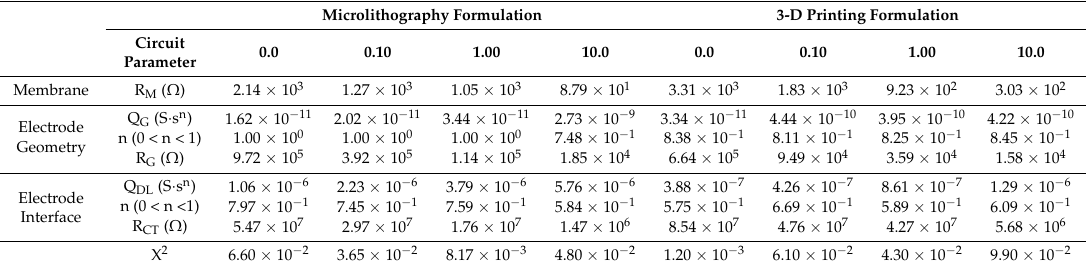
Figure 6. Nyquist plots of electroconductive hydrogels (ECH) containing 0.0, 0.1, 1.0, and 10 wt% PAn-PAAMPSA measured at room temperature (RT) in air from 10 mHz to 1.0 MHz using a 10 mV peak-to-peak sine wave. ( A ) Hydrogels formulated for microlithography containing 2 mol% pNVP and the equivalent R(QR)(QR) circuit (inset). ( B ) Hydrogels formulated for 3-D printing containing 12 mol% pNVP. Table 1. Equivalent circuit parameters extracted from impedance spectra shown in Figure 6.